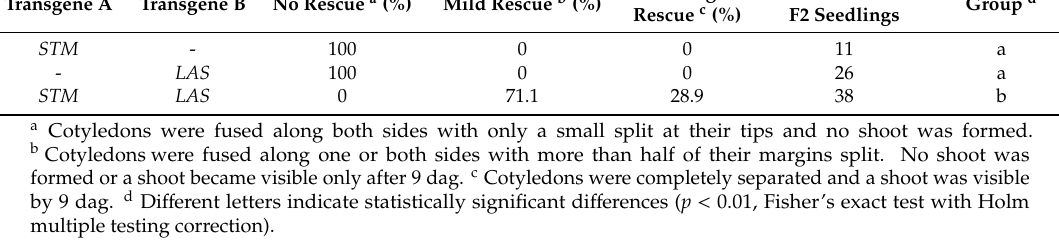
Table 2. E ff ect of combined expression of STM and LAS on the phenotype of cuc1 cuc2. Transgene A